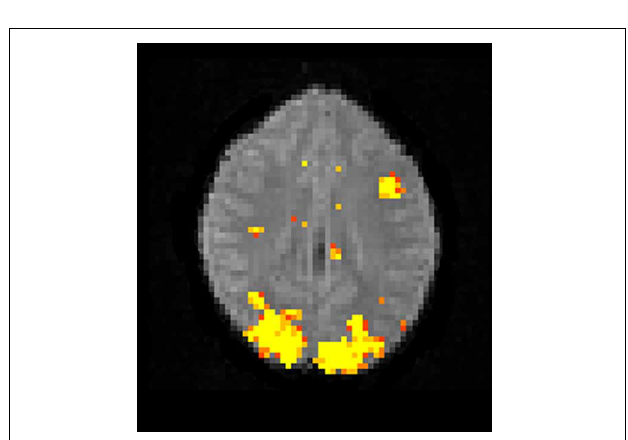
FIGURE 12 | A posterior probability map (PPM) from a Bayesian first level analysis of one OpenfMRI dataset. Subjects were presented with pairs of either words or pseudowords in a block based design, and made rhyming judgments for each pair. The first level analysis here includes motion correction, segmentation of the fMRI data, smoothing, and statistical analysis. The PPM represents the probability of the first GLM beta weight being larger than zero, and has been arbitrarly thresholded at a probability of 0.99. Note that the PPM has been calculated by using a Gibbs sampler, and not by using techniques based on variational Bayes. Also note that the frequentist approach uses a voxel-wise AR(4) model of the GLM residuals, while the Bayesian currently uses a voxel-wise AR(1) model (due to hardware